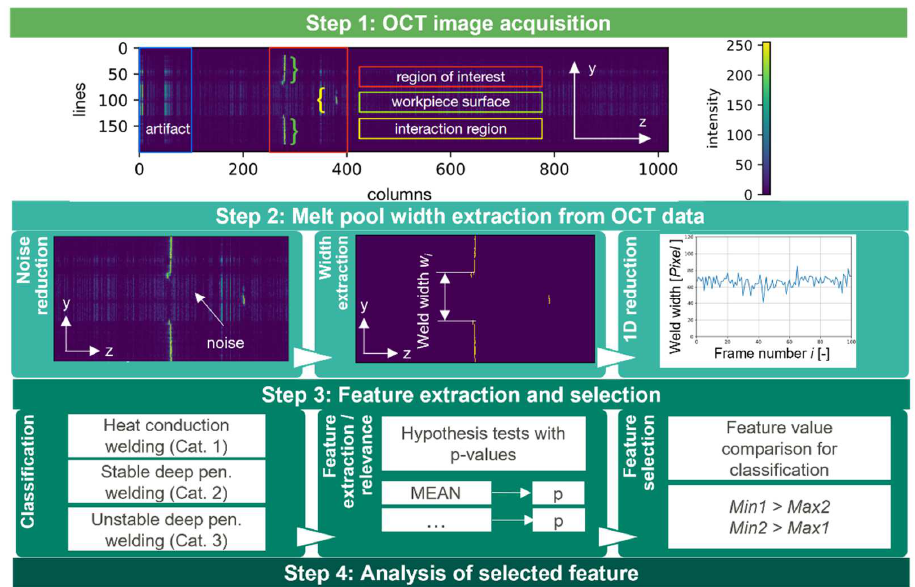
Figure 2. Four data processing steps for the identification of a relevant feature for the classification of laser process regimes based on OCT weld with